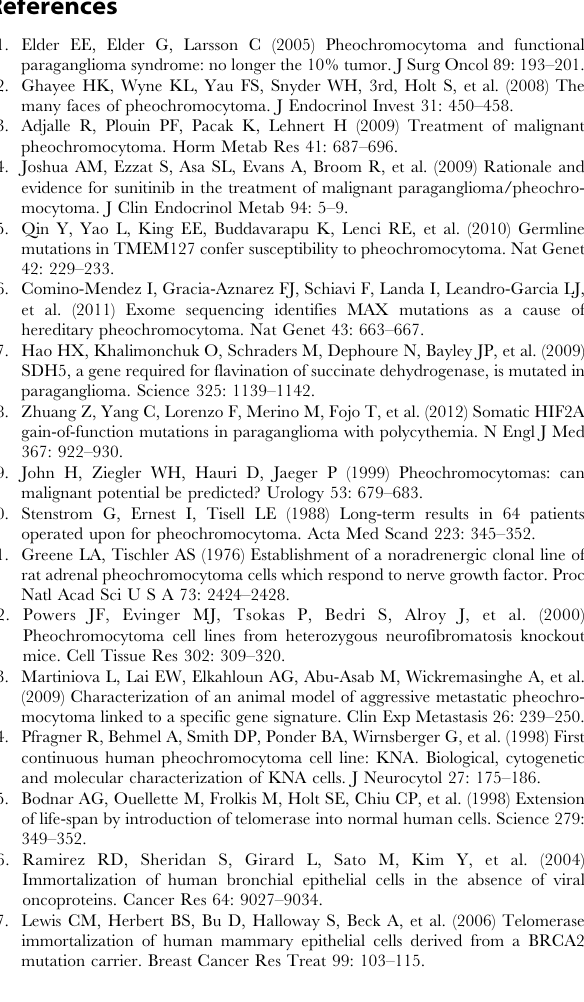
Figure S5 hPheo1 cells do not show